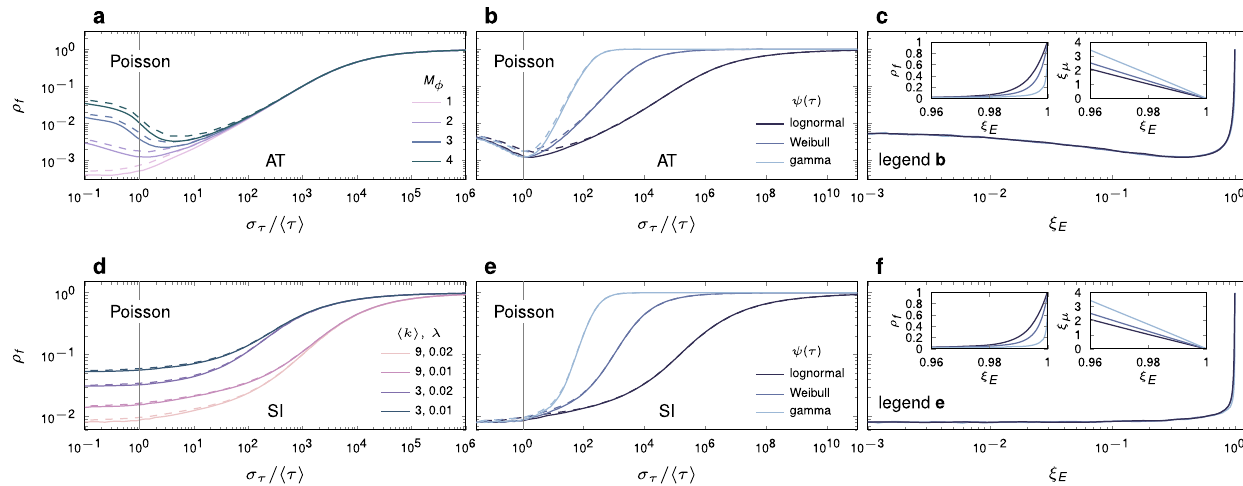
Fig. 3 Fraction of infections due to noise, ρ f , for various choices of interevent time distribution ψ ( τ ). Information diffuses following the AT, or absolute threshold model, a – c , and the SI, or susceptible-infected model, d – f . Analytic solution is denoted by dashed lines, and Monte Carlo results by solid lines. a Effect of absolute threshold M ϕ . b Dependence of ρ f on choice of ψ ( τ ). c Data collapse of b after controlling for effective sparsity ξ E . Left inset is a closeup of the main plot in linear scale, revealing that differences in ρ f remain after controlling for ξ E . This is explained by the differing mixing rates ξ μ (inset right). e , f Corresponding results for the SI model. Cutoff node density is ρ c = 0.4, with η = 〈 τ 〉 = 1. Analytic solution is shown by dashed lines, Monte Carlo simulations by solid lines. Degree distribution is lognormal with 〈 k 〉 = 7 and σ k = 1. We use a threshold M ϕ = 2 for the AT model, λ ¼ 0 : 02 in the SI model, and external noise p = 2×10 − 4 in each. Monte Carlo simulations involve 10 4 realisations on networks of size N = 10 6